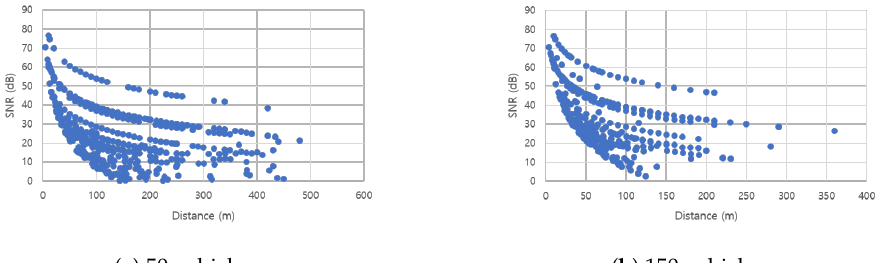
Figure 14. SNR vs Distance by simulation.